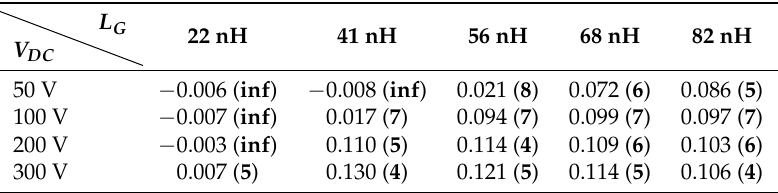
Table 6. A comparison between the ζ 2 and number of oscillation cycles N C ( bold ) with various L G and V DS with L C = 460 nH, R G = 1.5 Ω